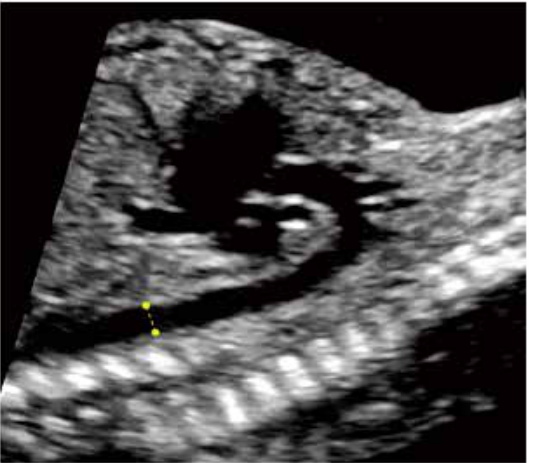
Figure 1 Measuring the maximum systolic ADDH in aortic arch